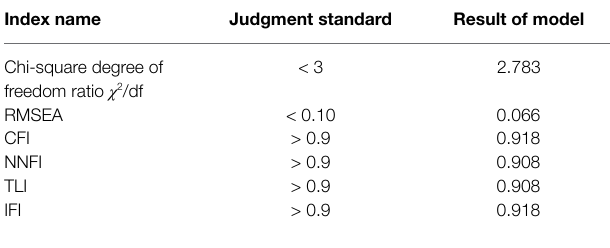
TABLE 5 | Fitness of model.